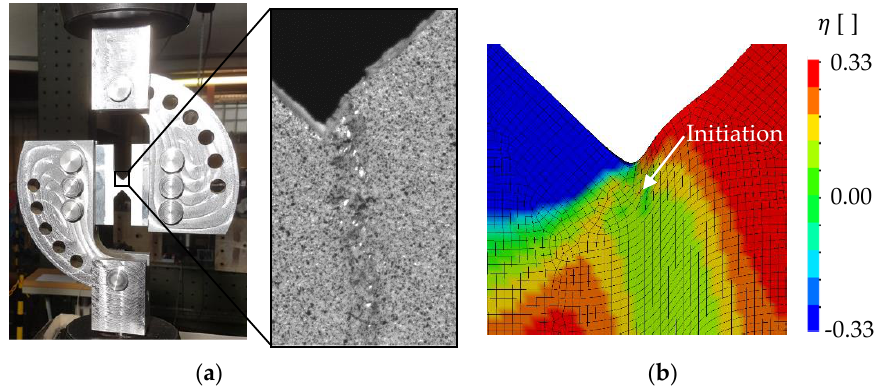
Figure 9. Fracture behavior at the surface of the BM shear specimen in ( a ) the experiment and ( b ) finite element (FE) simulations with the BW criterion.